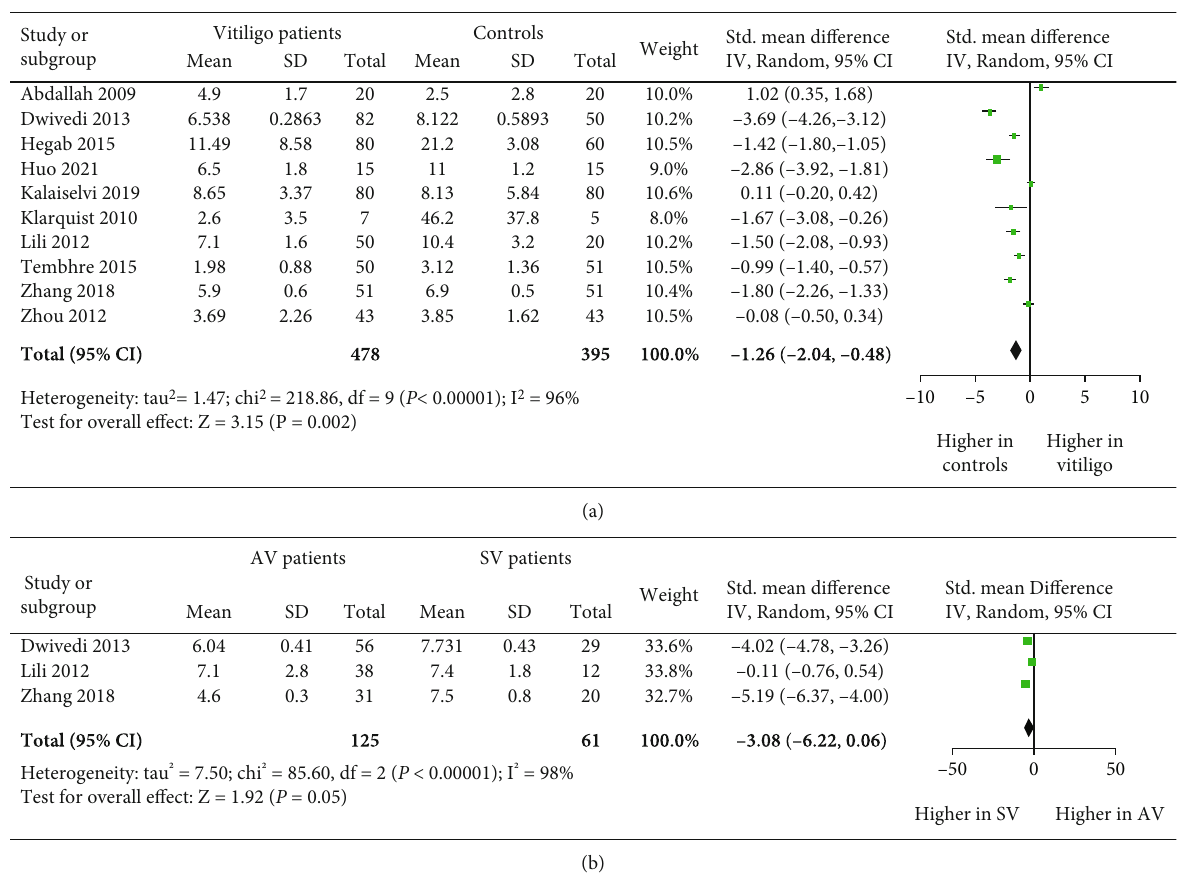
Figure 2: The forest plots for Treg cells ’ frequency in vitiligo patients and controls. (a) Treg cells ’ frequency in vitiligo patients vs. controls ( p = 0 : 002 ; SMD: -1.26 [-2.04, -0.48]). (b) Treg cells ’ frequency in AV vs. SV patients ( p = 0 : 05 ; SMD: -3.08[-6.22,